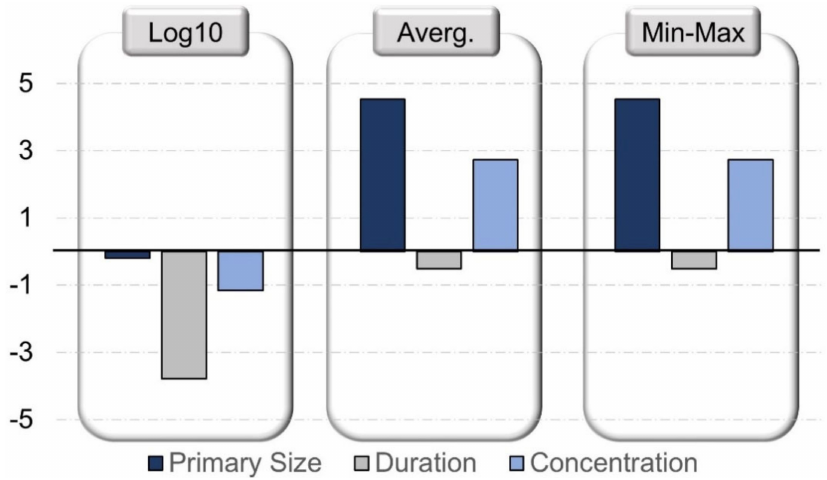
Figure 3. Data skewness of numerical inputs (primary size, duration, and concentration) was based on the three different normalization techniques (log10, mean, and min −